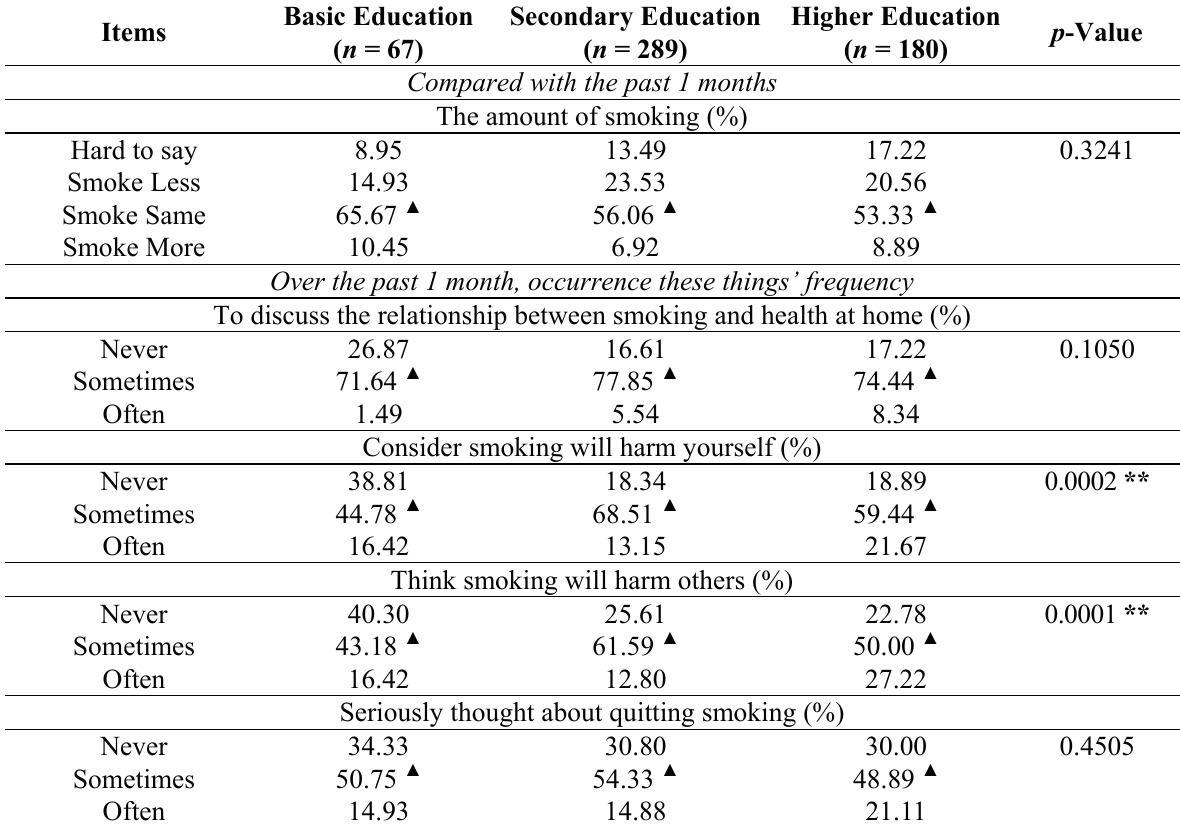
Table 4. Smoking-related behavior, Chongqing, China,